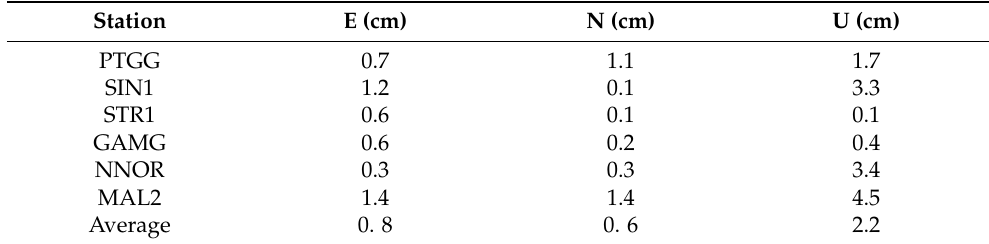
Figure 14. Average RMS accuracy of the real-time kinematic PPP at each station. Table 3. Average RMS accuracy